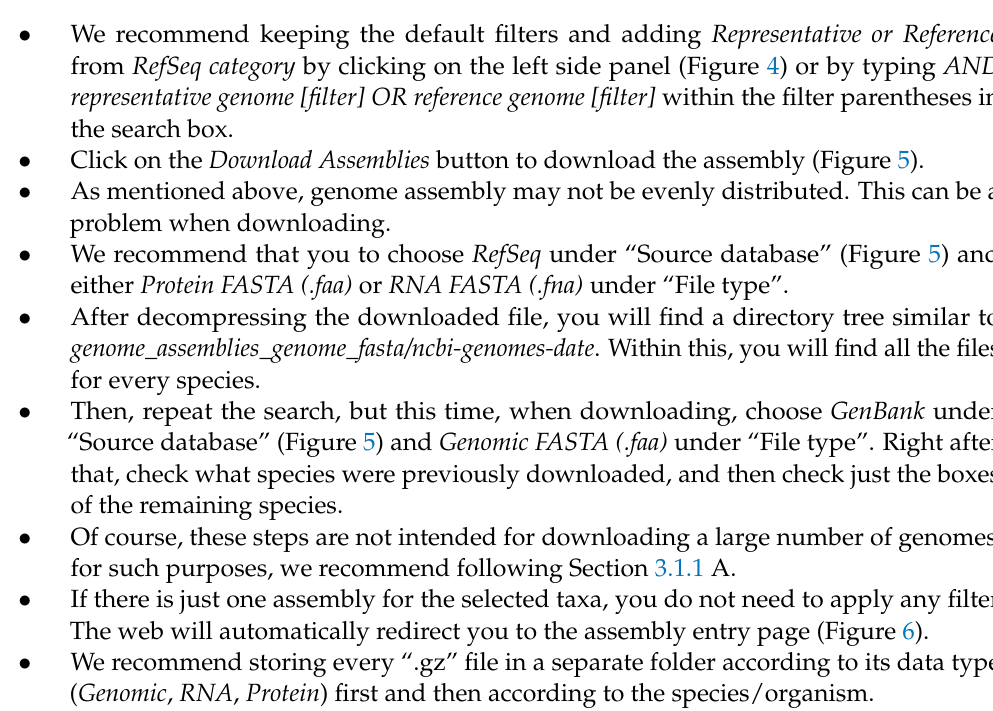
Figure 5. Download Assemblies button in detail. Accessed on 27 January 2022.